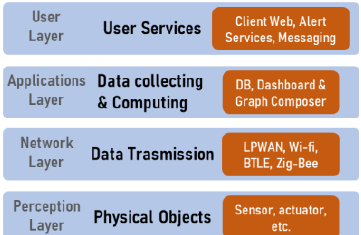
Figure 1. IoT System